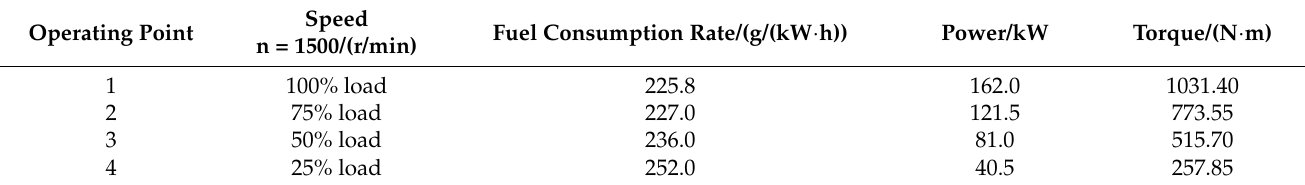
Table 7. Diesel engine load characteristics of 6135G128ZCa.